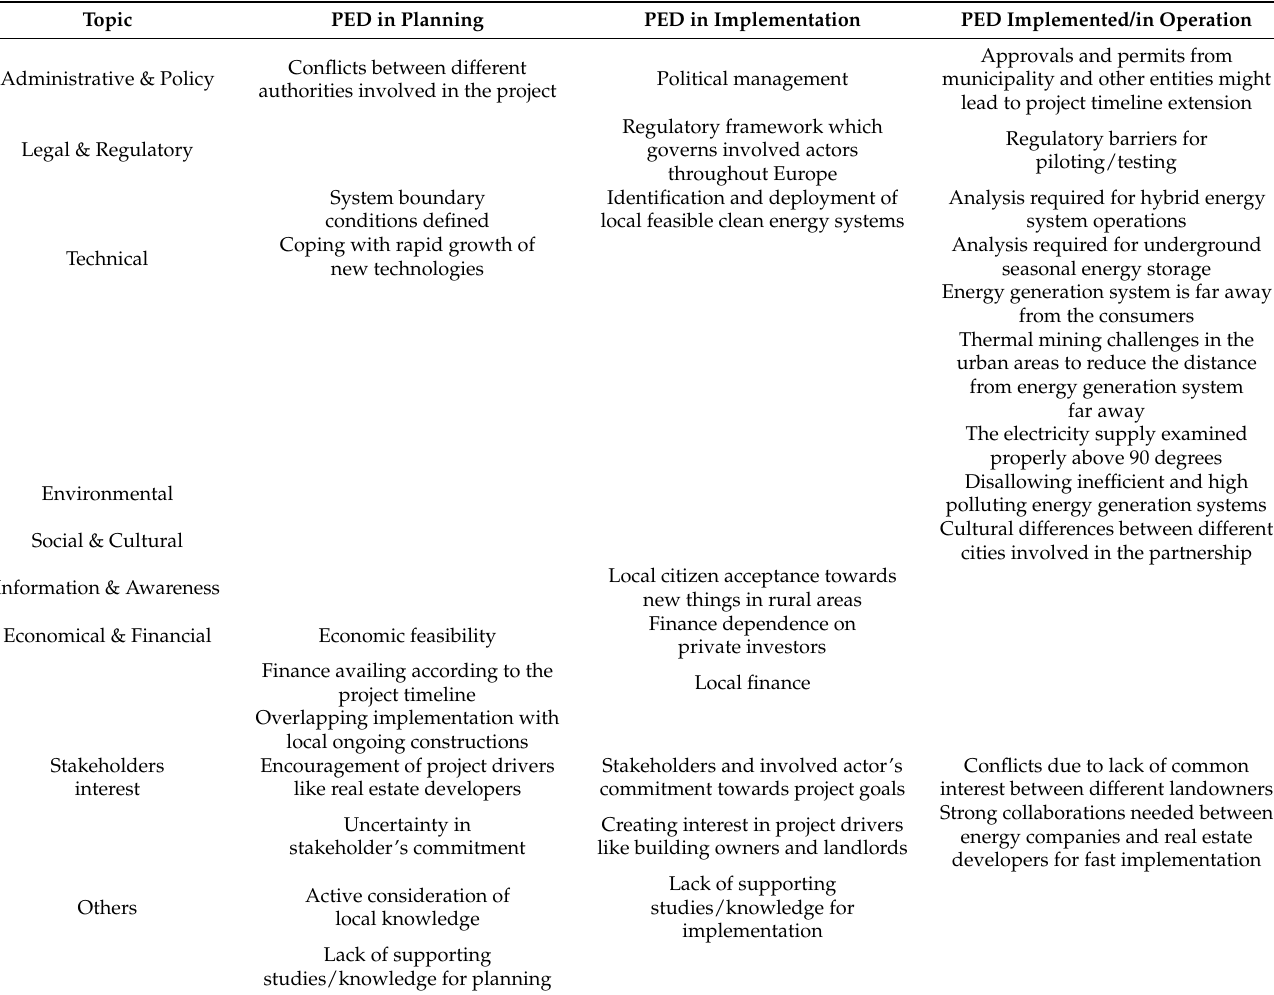
Table 3. Challenges and barriers in different stages of PED projects according to the main